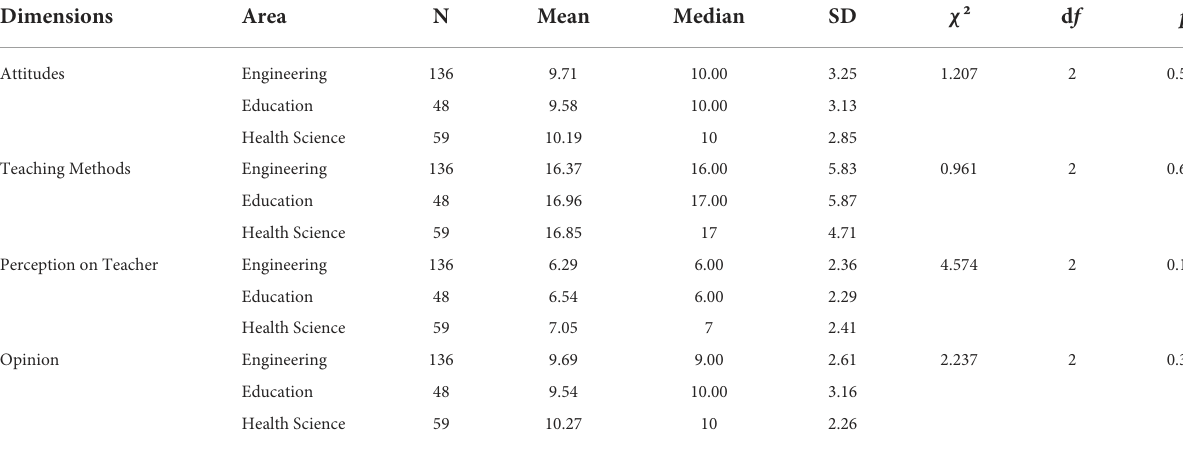
TABLE 5 Kruskal–Wallis H results according to departments.